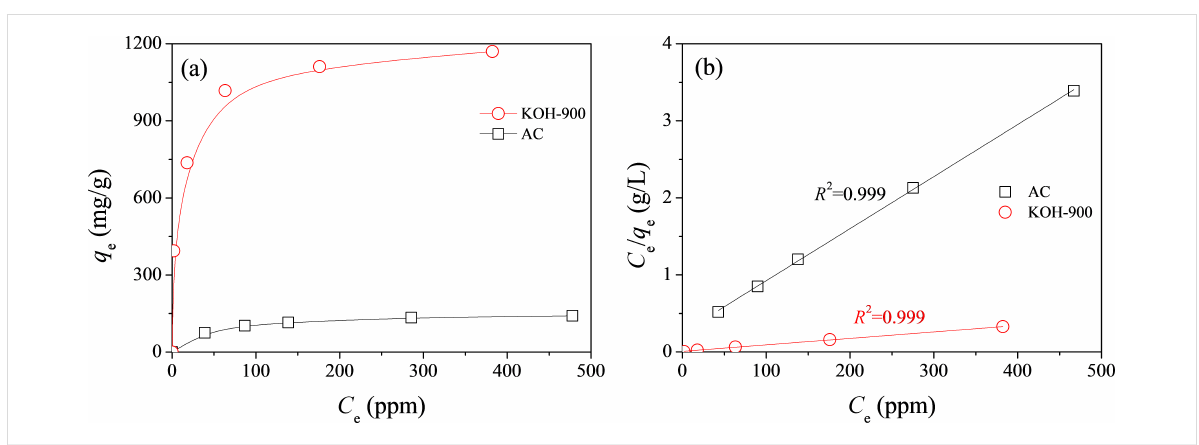
Figure 6: (a) Adsorption isotherms and (b) Langmuir plots for the adsorption of AR1 from water over AC and KOH-900.